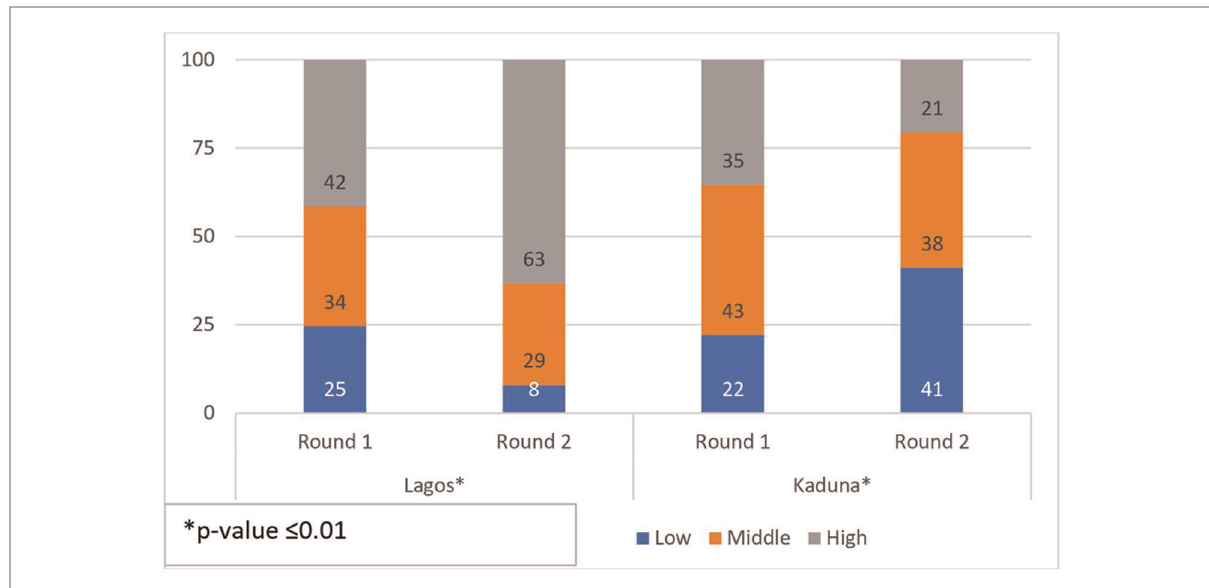
FIGURE 3 Bivariate association of quality of care by round and by